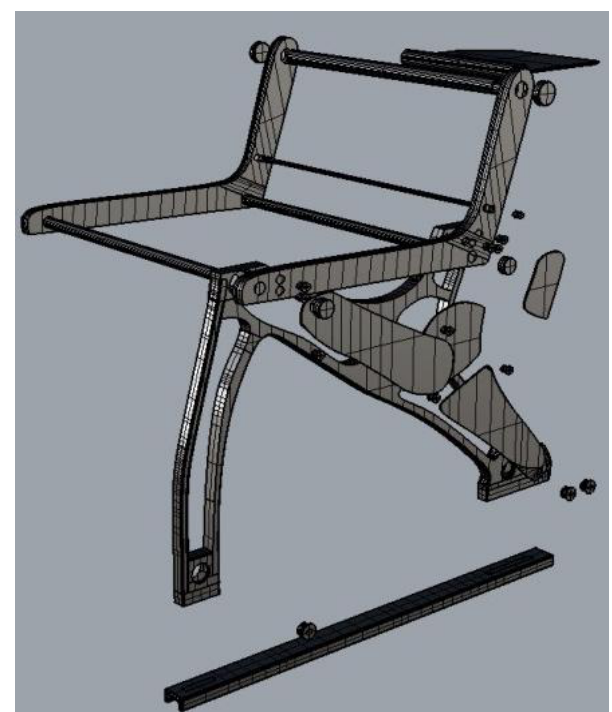
Figure 37. Individual front components.